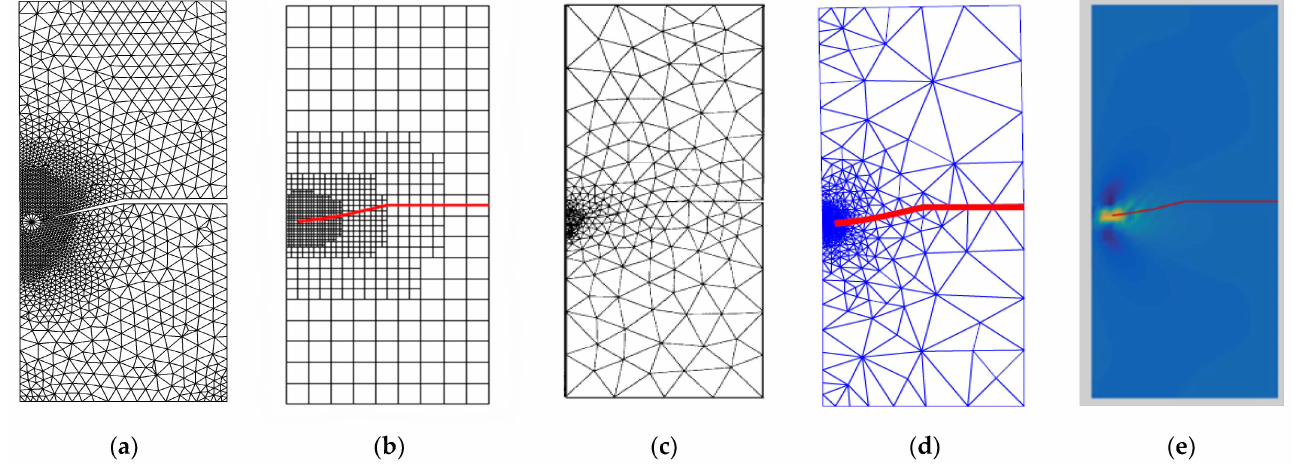
Figure 10. Predicted crack growth path, ( a ) present study, ( b ) numerical results [46], ( c ) numerical results [43] ( d ) numerical results [45], ( e ) numerical results [47].